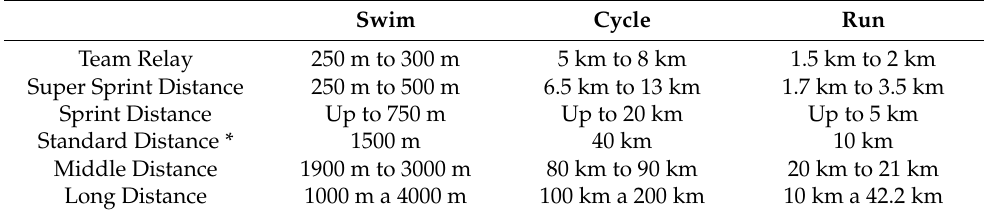
Table 1. Official distances in